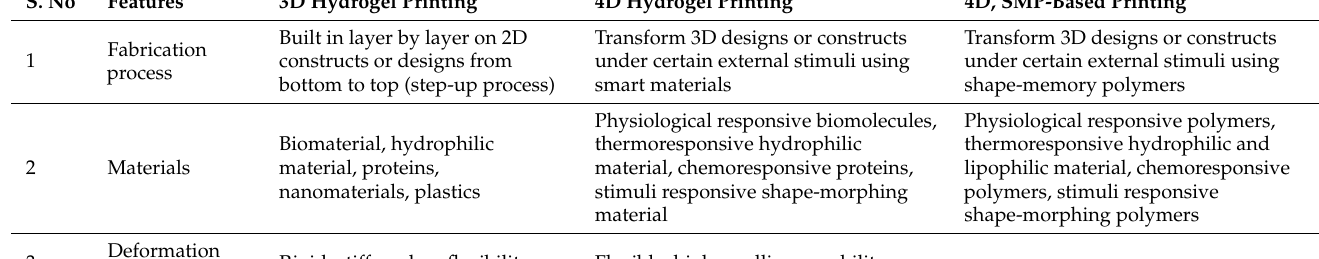
Table 1. A comparative analysis of conventional 3D hydrogel printing, 4D hydrogel printing, and 4D, SMP-based printing [7–13]. S. No